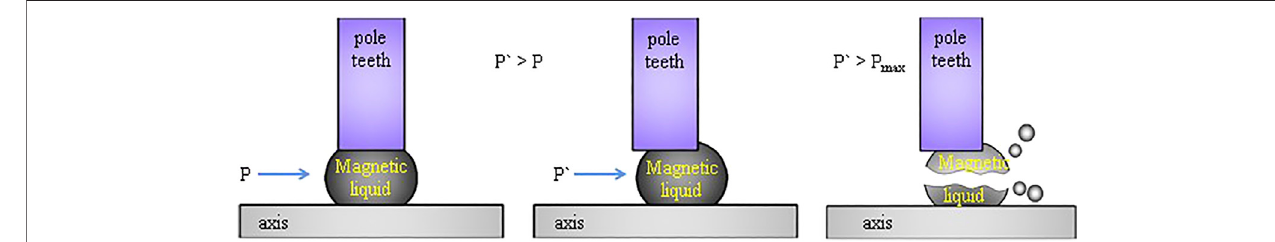
FIGURE 1 | The sealing fi lm fl uctuates and breaks.